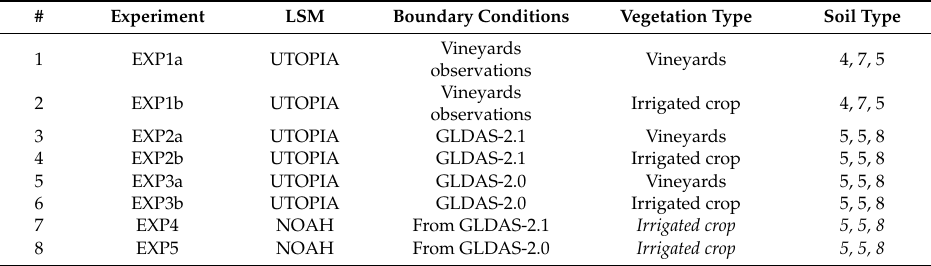
Table 3. Summary of experiments performed, with the explicit indication of the boundary condition used, as well as vegetation and soil types. For NOAH, we have retrieved the data from the GLDAS web site. Italic style indicates that the types of vegetation and soil were set by the GLDAS team. For soil types, the three numbers refer, respectively, to the sites: CF, CO, and FB. The used soil types are thus defined in the following way: 4 (silt loam), 5 (loam), 7 (silty clay loam), 8 (clay